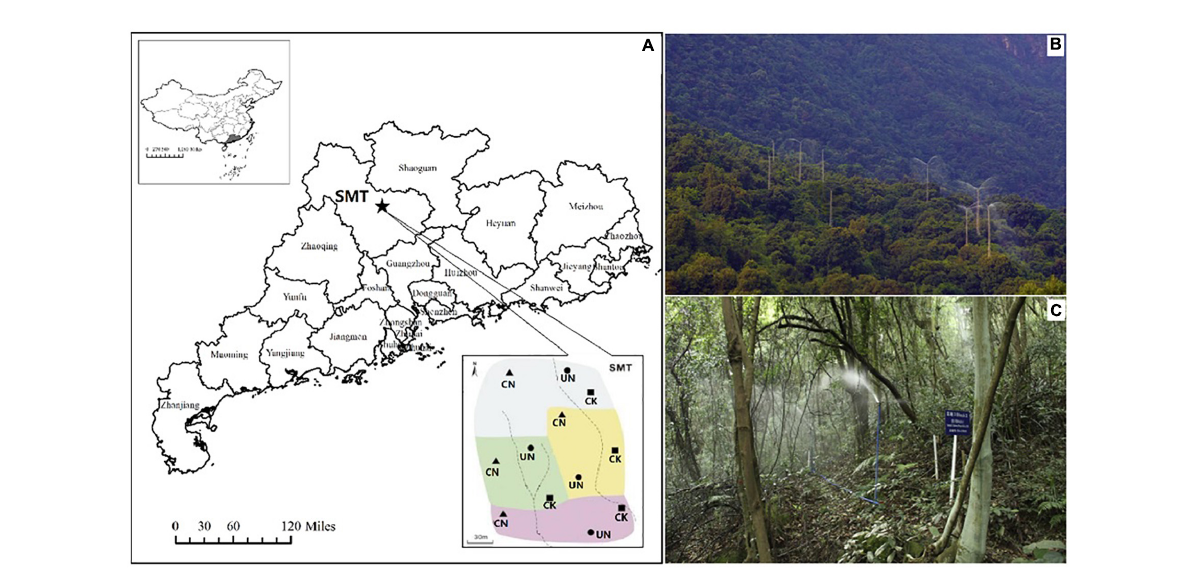
FIGURE1 Geographical location and plot layout of the experiment (A) and the setups for canopy (B) and understory (C) N addition. CK, CN, and UN represent control conditions, canopy N addition, and understory N addition, respectively. Pictures of (B,C) were taken by Liu N. et al. (2020).